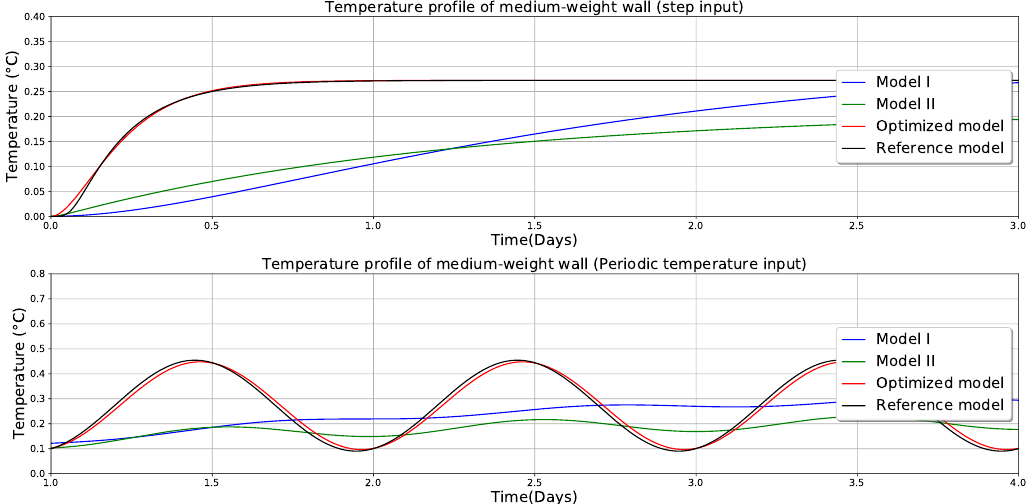
Figure 4. Temperature dynamics of reference, optimized and comparison models for light weight wall.